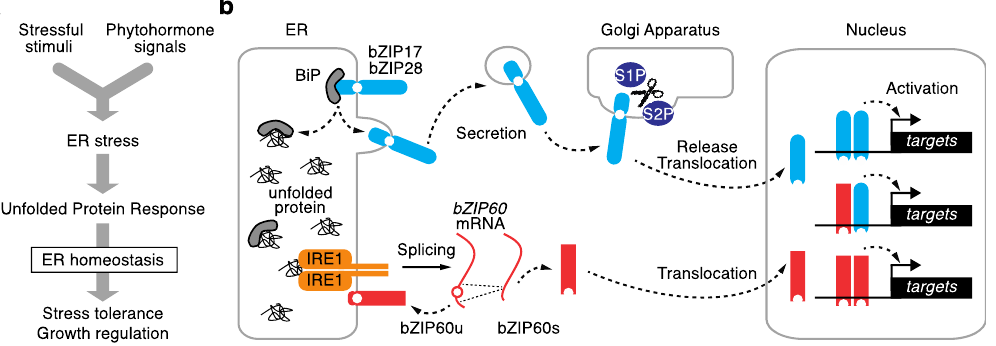
Figure 1. Schematic view of the plant ER stress signaling pathway. ( a ) The plant ER stress response transduces both exogenous stress stimuli and endogenous phytohormone signals into the unfolded protein response (UPR) to govern stress tolerance and growth regulation. ( b ) Two eukaryote-wide UPR pathways are activated by distinct pathways. Arabidopsis bZIP17 and bZIP28 are activated by post-translational proteolysis at the Golgi apparatus, and bZIP60 is activated by alternative splicing. The activated bZIPs are translocated to the nucleus, where they activate downstream target genes.